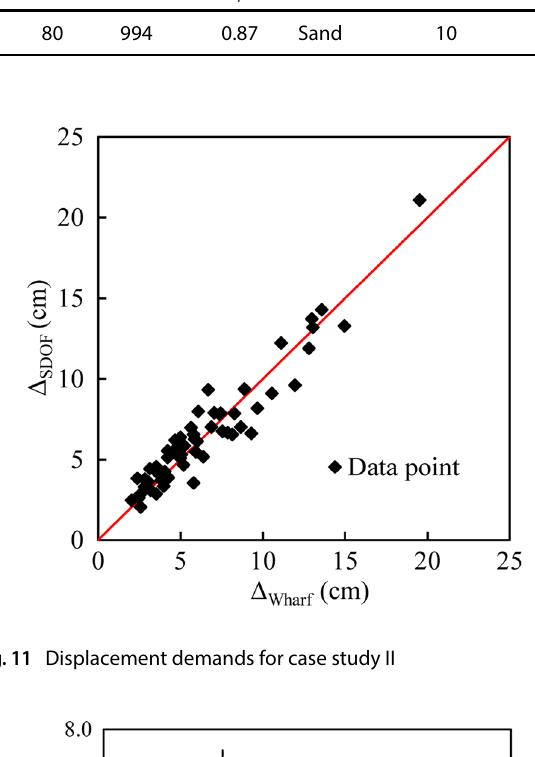
Table 3 Properties of piles and dike soil for case study II